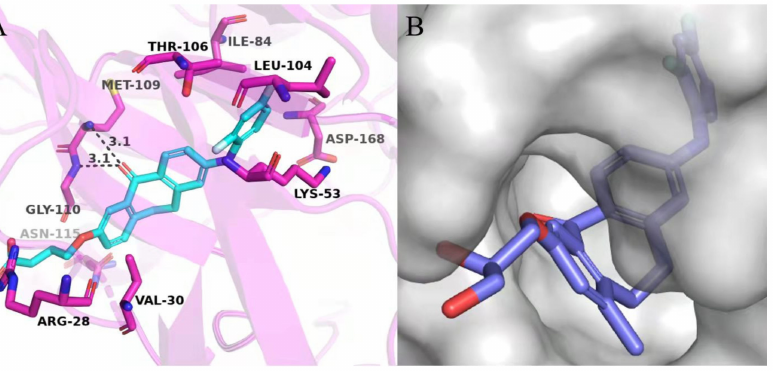
Figure 4. ( A ) Predicted binding mode of 13a with MAPK11; ( B ) Surface binding model of 12b with MAPK11. The structure of MAPK11 is shown in red cartoon (PDB ID: 3GC8), 13a and 12b are shown as sticks. The key residues are presented in purple sticks and labeled, and the H-bond interactions are depicted as black dashed